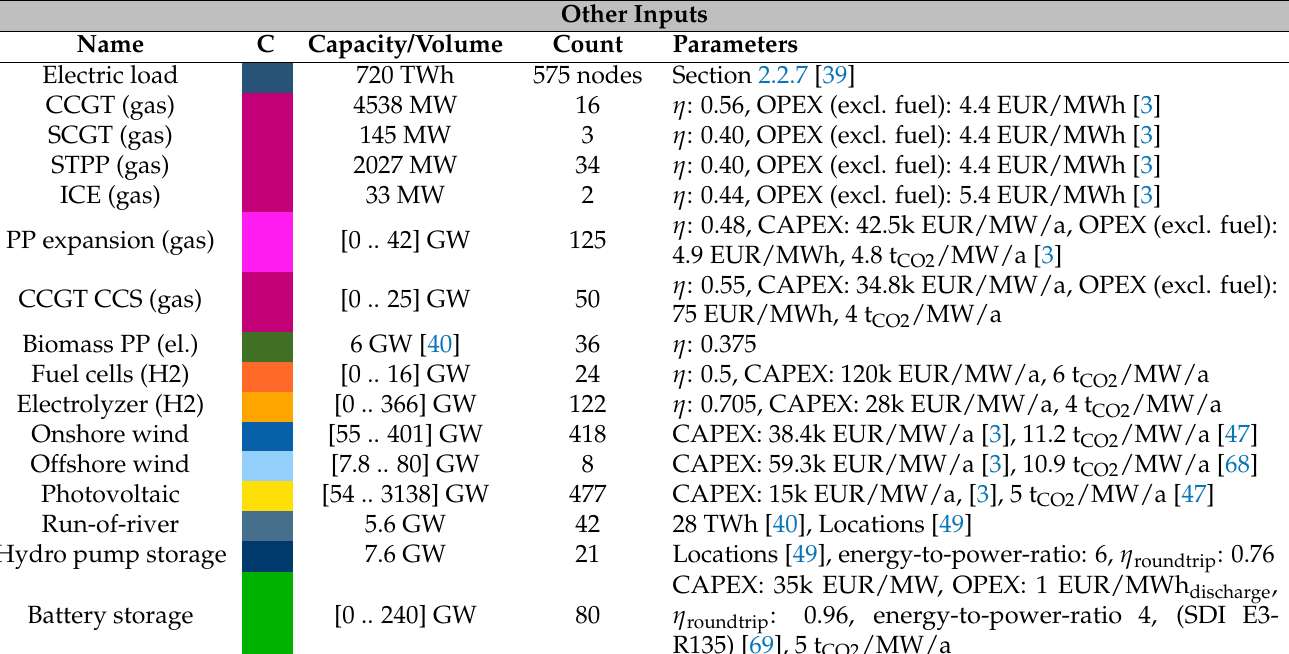
Table A2. Relevant parameters for technologies not directly related to heating. Other Inputs